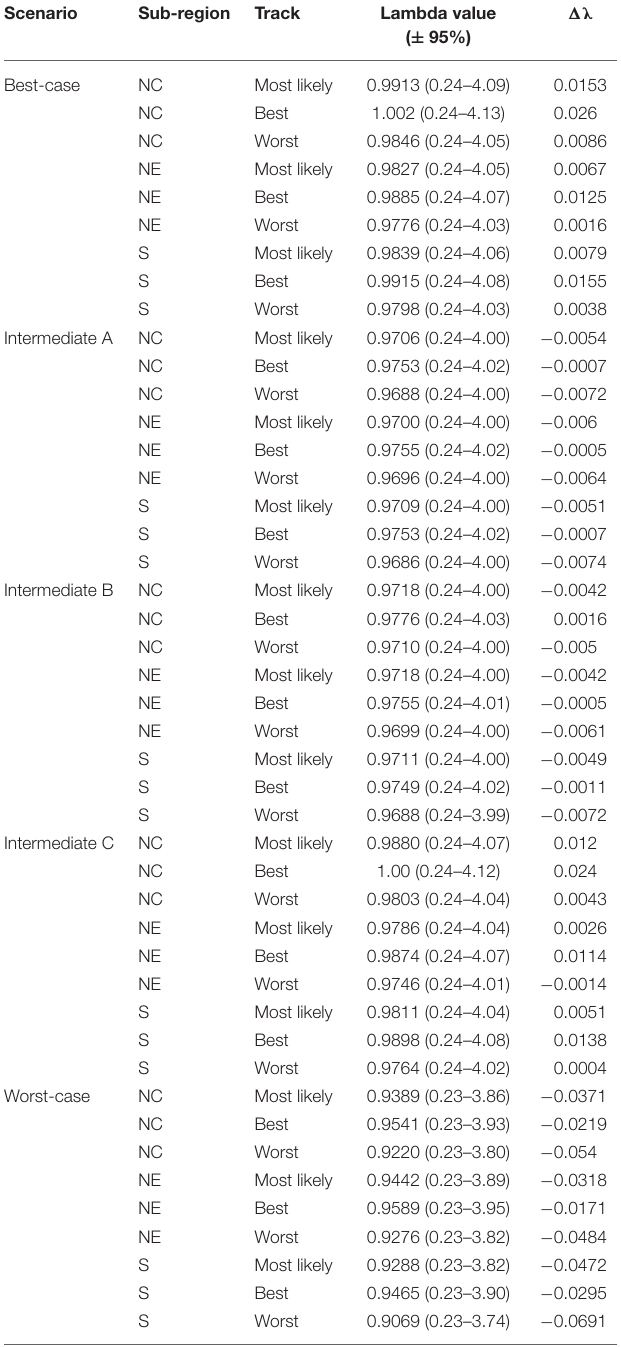
TABLE 4 | Eastern population scenario specific λ values, per sub-region, with 95% confidence intervals after incorporating scenario specific